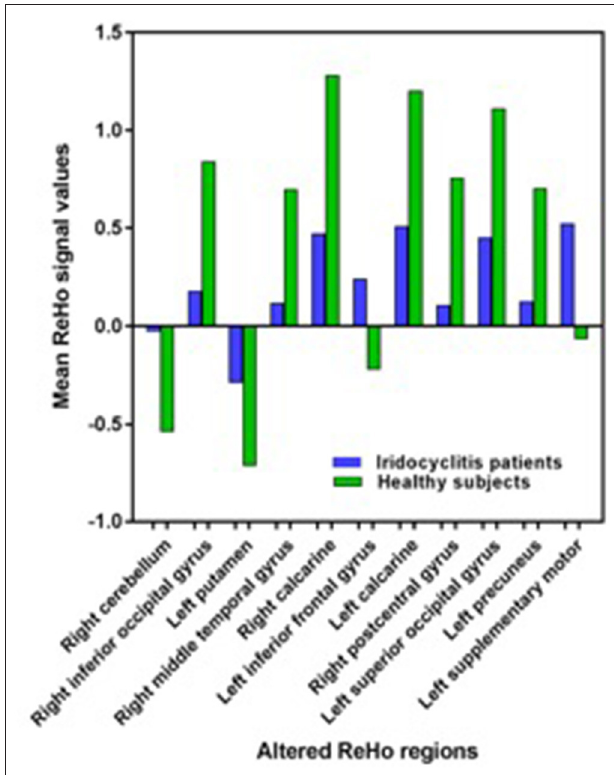
FIGURE 4 | The average values of changed ReHo signal values between the iridocyclitis patients and healthy volunteers.